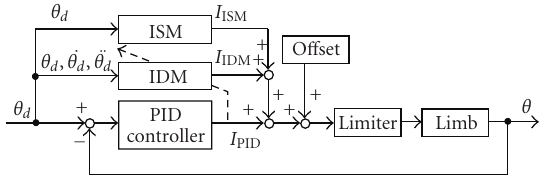
Figure 1: Feedback error learning controller tested in this study. The inverse statics model (ISM) and inverse dynamics model (IDM) were used as the feedforward controller.